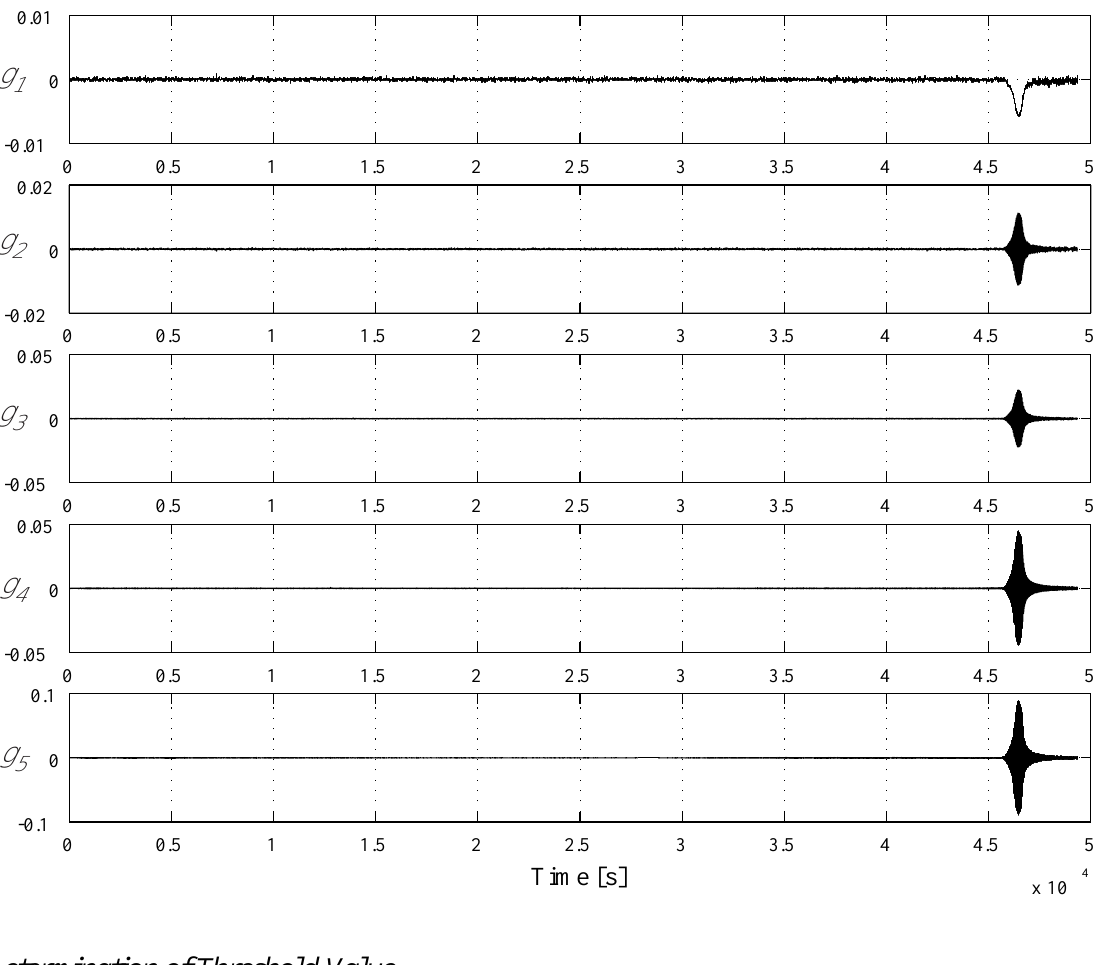
Figure 5. Result of the wavelet analysis